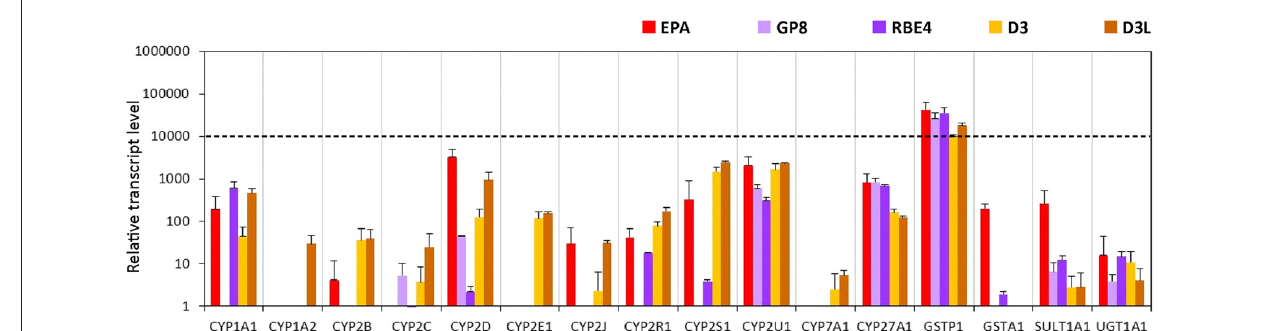
FIGURE 8 | Relative transcript levels of selected genes encoding metabolic enzymes measured by inventoried TaqMan Gene Expression Assays in a primary rat brain endothelial cell-based BBB model (EPA) and in brain endothelial cell line models (GP8, RBE4, D3 and D3L).